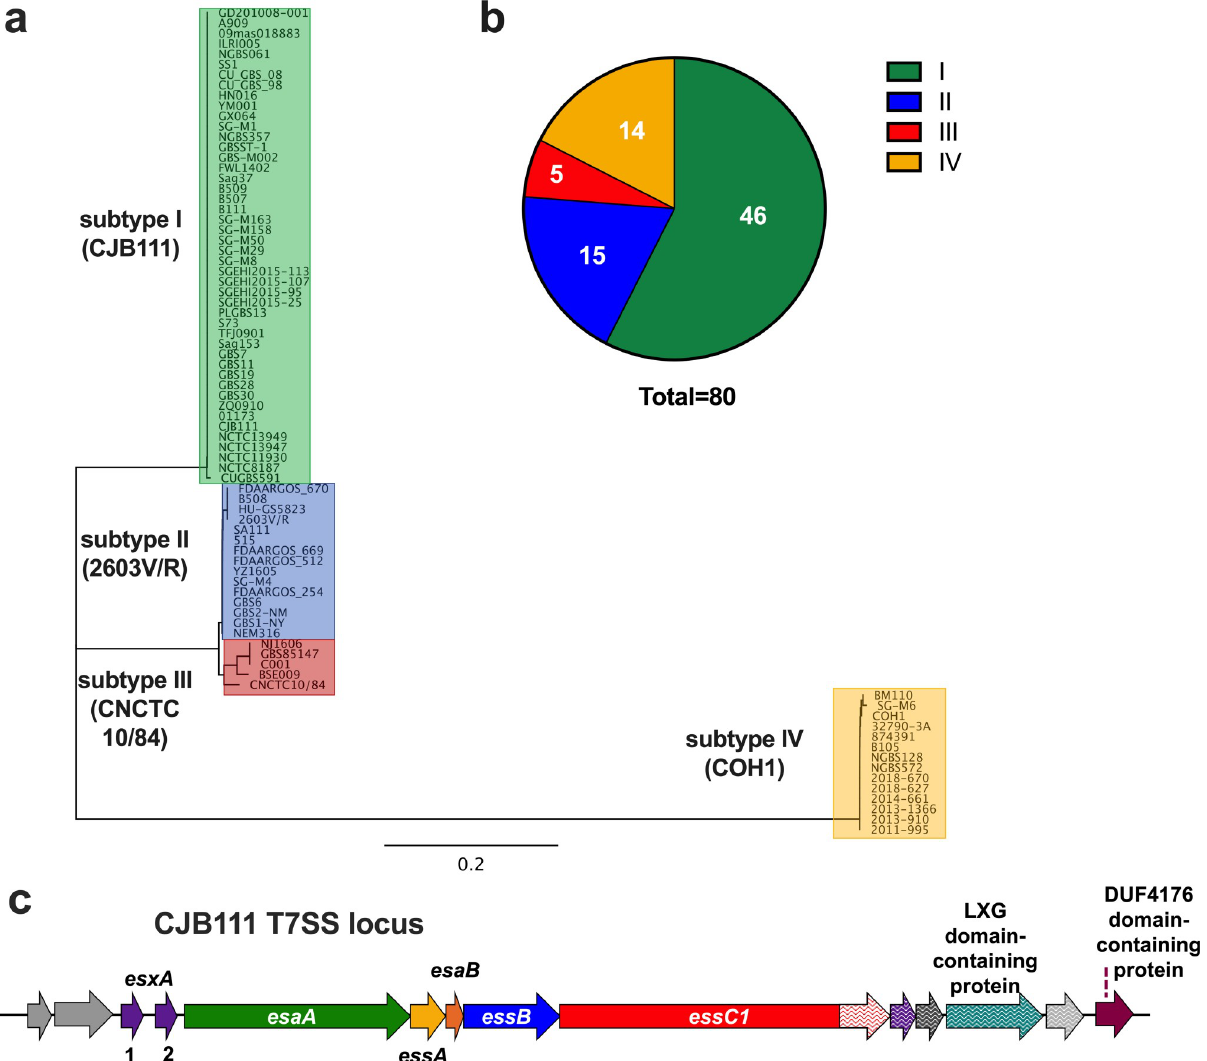
Fig 1. Genomic analysis of GBS T7SS subtypes and characterization of the GBS T7SS operon in subtype I strain, CJB111. a) Phylogenetic tree of whole-genome sequenced GenBank isolates that encode the C-terminal 225 amino acids of EssC. Subtype I strains (example strain CJB111; n = 46) are highlighted in green, subtype II strains (example strain 2603V/R; n = 15) are highlighted in blue, subtype III strains (example strain CNCTC 10/84; n = 5) are highlighted in red, and subtype IV strains (example strain COH1; n = 14) are highlighted in yellow. b) Distribution of GBS T7SS subtypes based on EssC C-terminus in whole-genome sequenced GBS isolates that encode T7SS (n = 80). c) Diagram of the T7SS locus in CJB111 (roughly to scale; accession CP063198.2). Genes in purple encode WXG100 or WXG100-like proteins, gene in teal encodes a LXG domain-containing protein, and gene in maroon encodes a DUF4176 domain-containing protein. Genes in various shades of gray are either annotated as hypothetical or do not have a predicted function. Arrows with patterns indicate T7SS subtype-specific genes that exhibit little to no homology to those present in other GBS T7SS subtypes. Putative core genes of the operon are esaA through essC